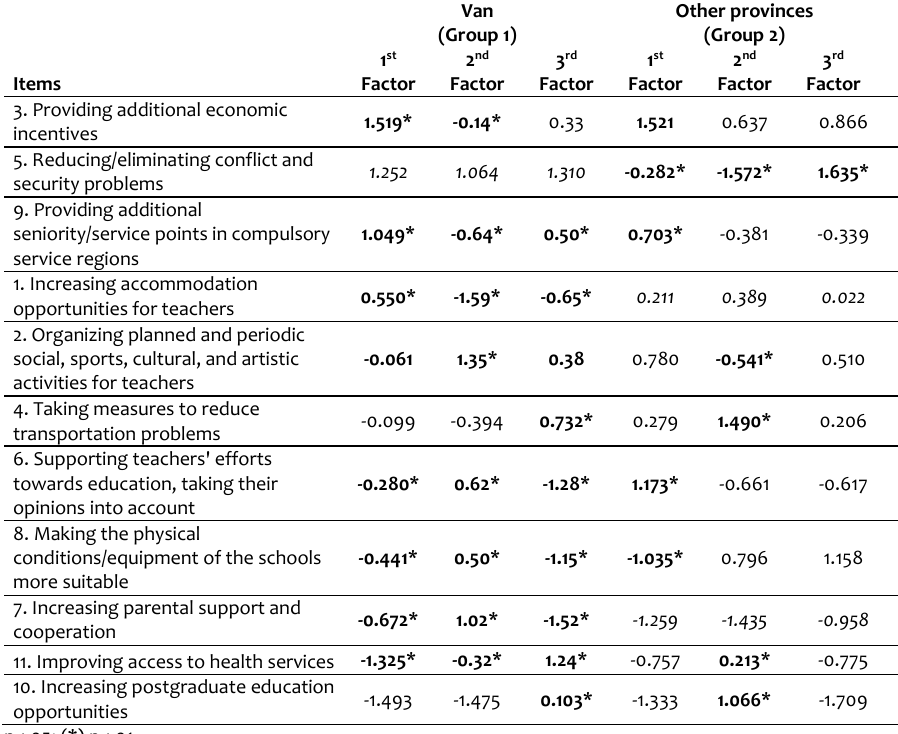
Table 6. Factor-Based Z Score Distributions and Distinctive Items Related to the Solutions Towards Teacher Turnover